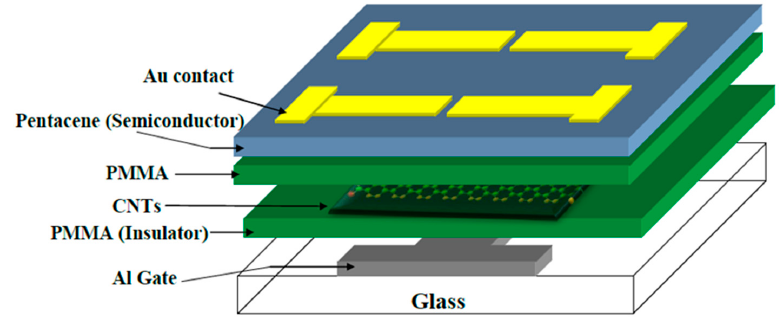
Figure 1. Schematic diagram of the single-walled carbon-nanotubes (SWCNTs)-based organic thin film memory transistors (OTFMT) with SWCNTs floating gate.